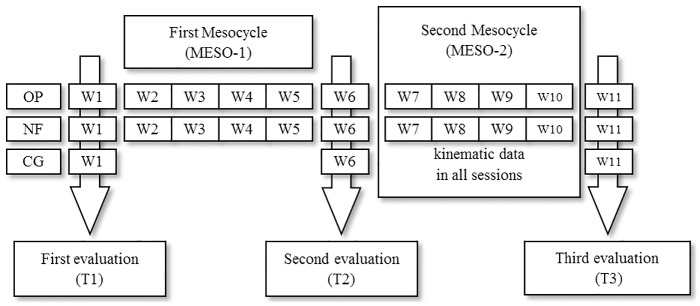
Experimental design.